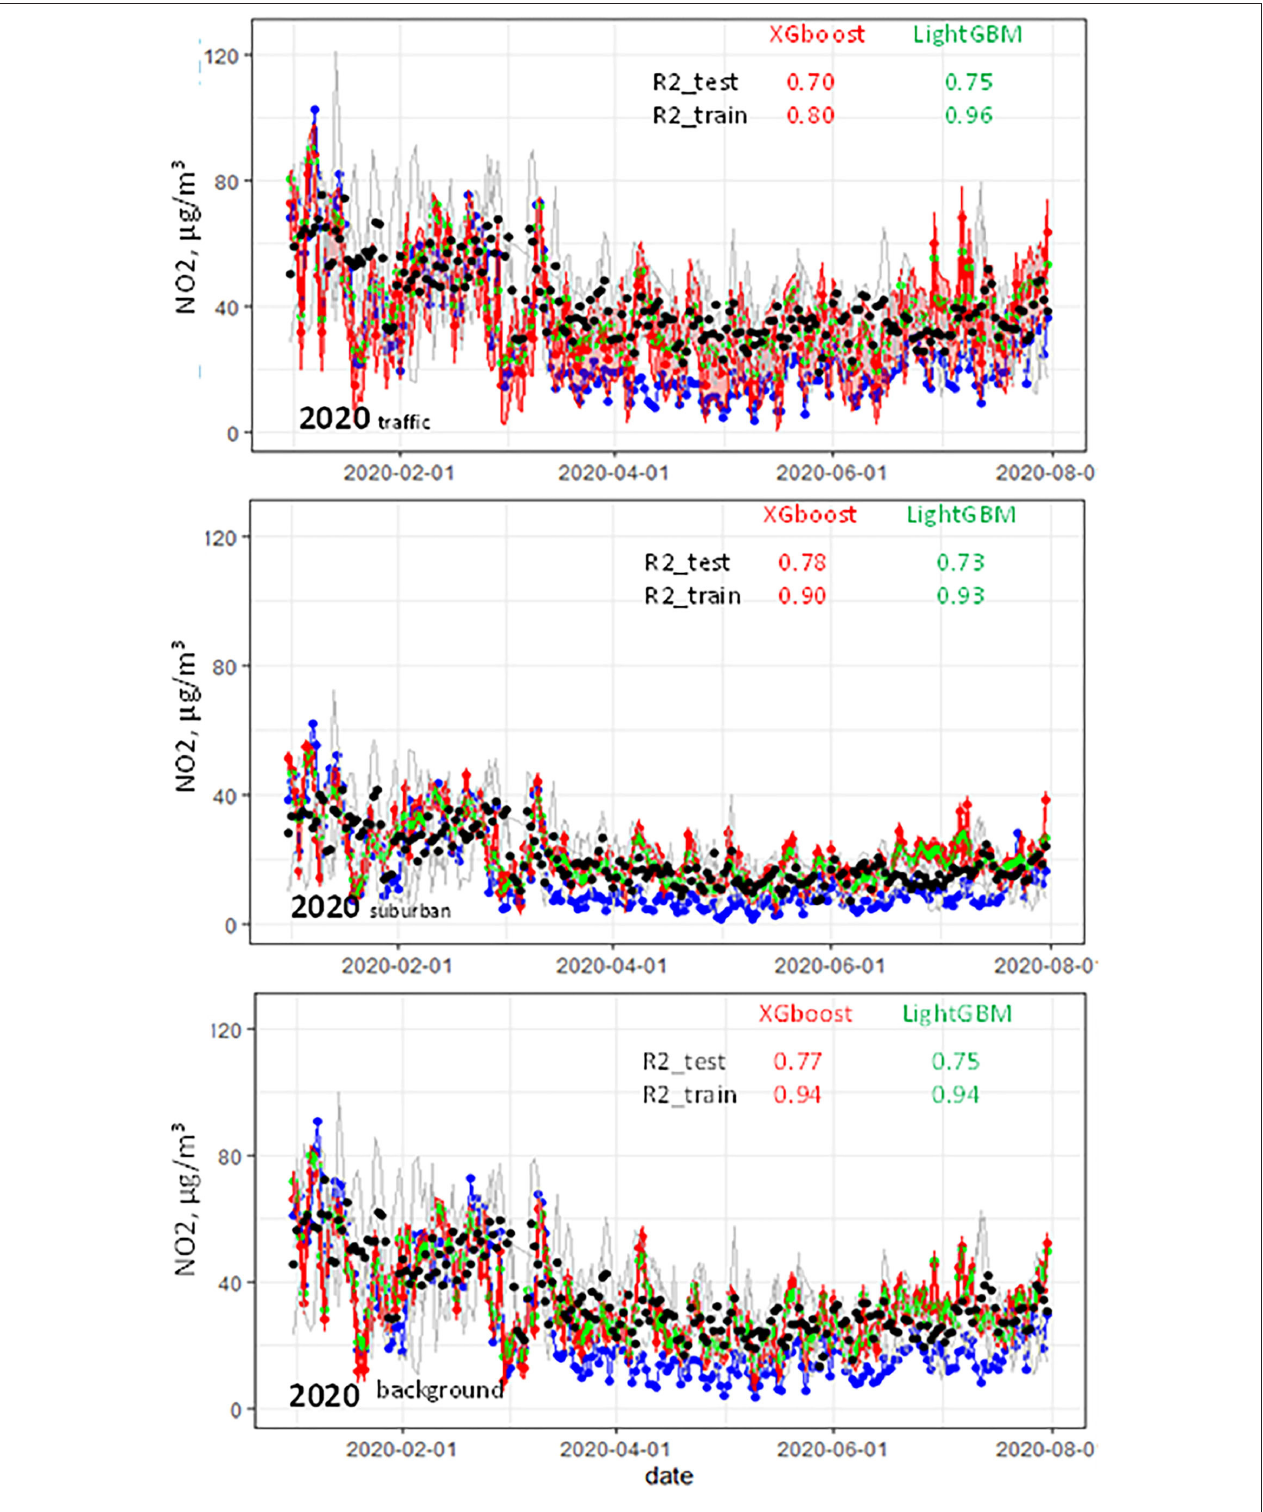
FIGURE 7 | The NO 2 time series for the air quality stations (AQSs) in Madrid, aggregated by type, previously and during the COVID lockdown. The LightGBM and XGBoost predictions are shown in green and red, respectively. The AQS observations are shown as the blue line and points. The concentrations over the past 3 years are represented as gray lines, whereas the black points indicate their average. A weekly moving average was used to smooth the data.